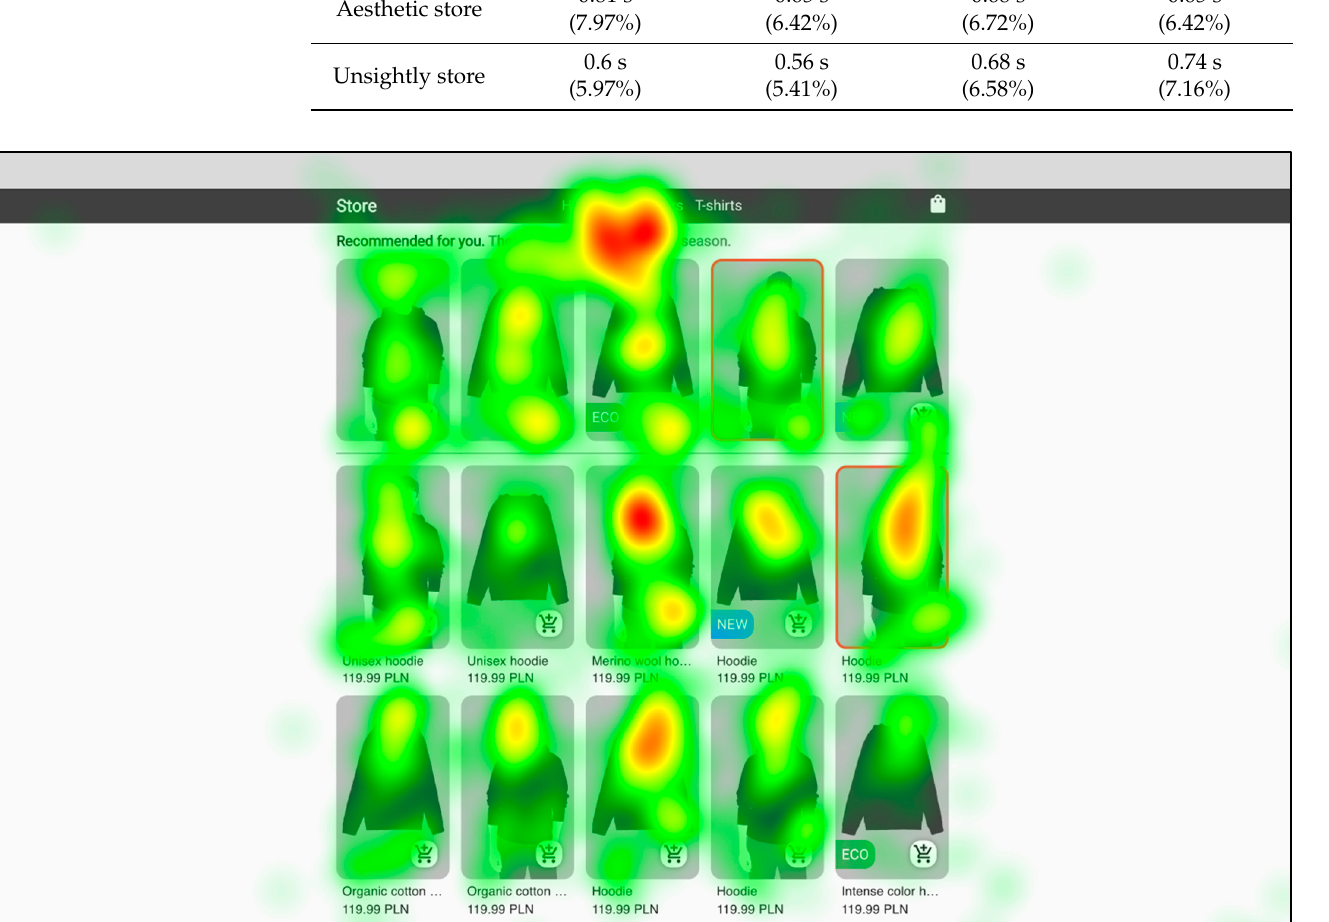
Figure 7. Aggregated heatmap of all participants for the first category (hoodies or skirts) in the un- sightly store. (The pictures of clothes and models are illustrative).